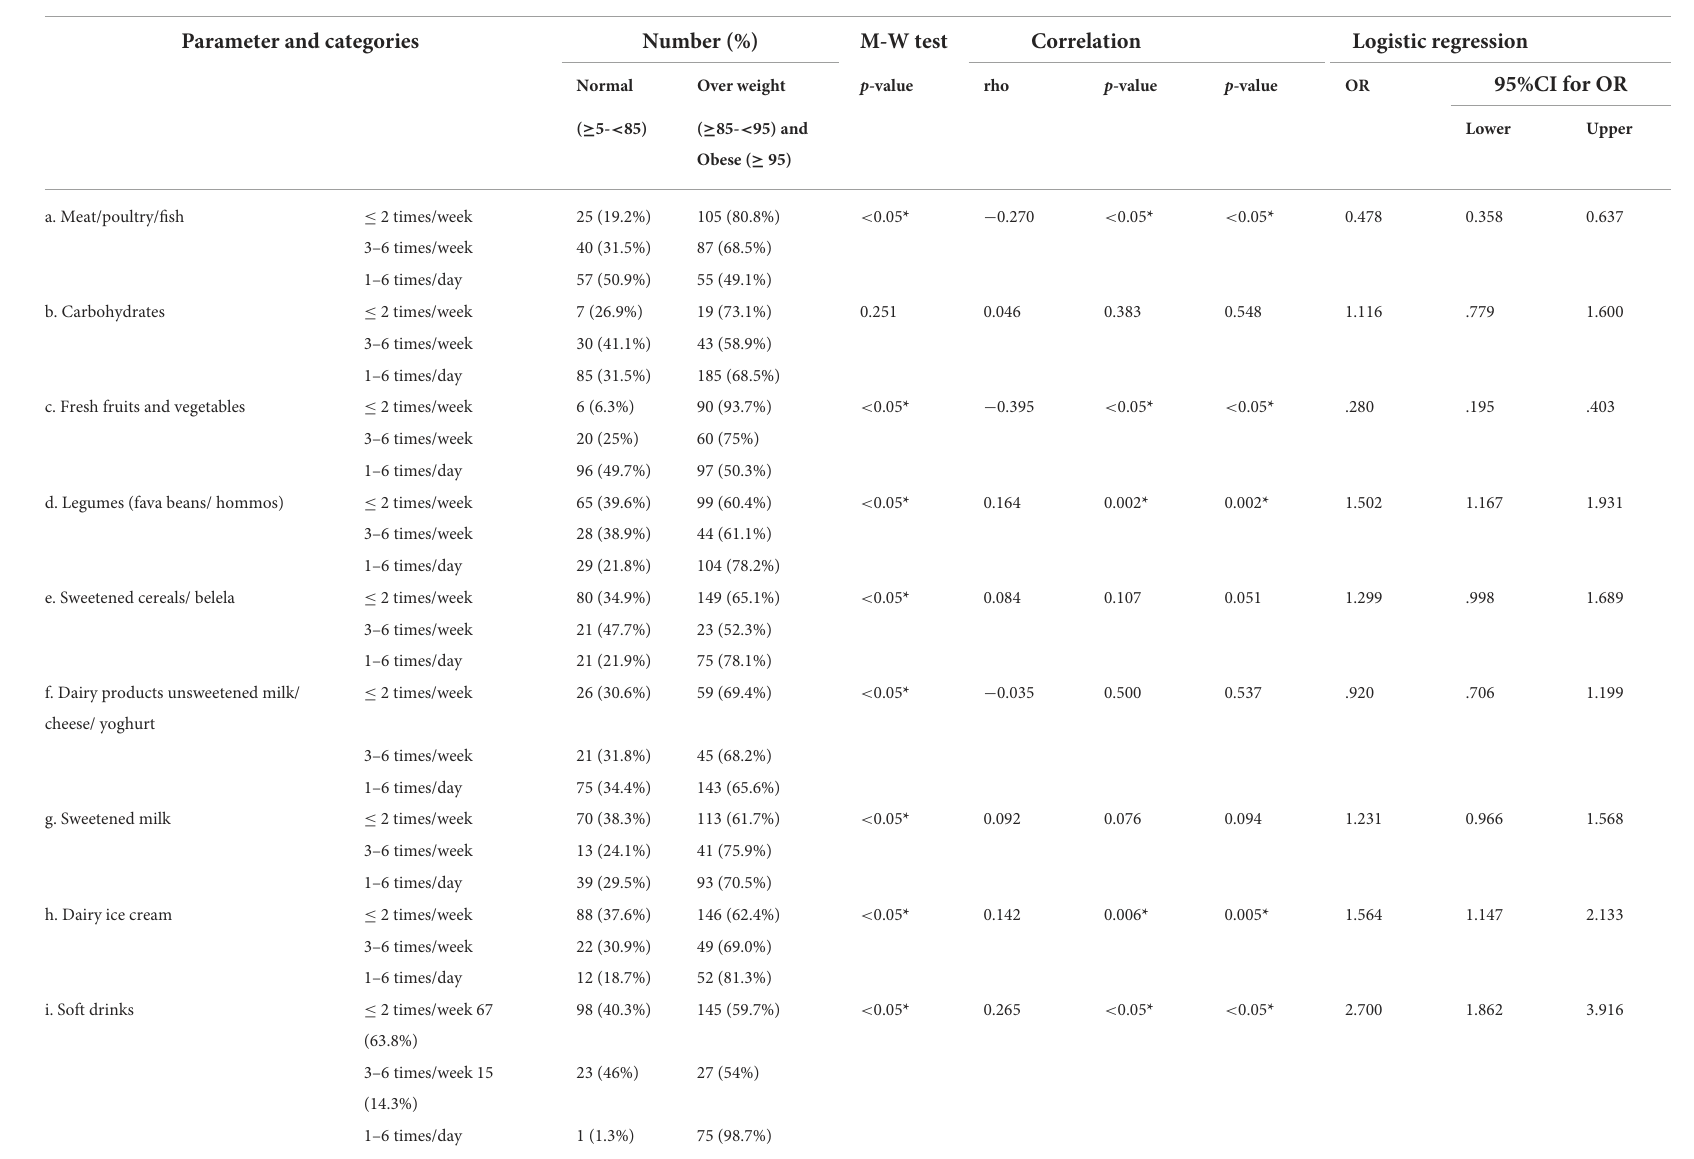
TABLE 11 Correlation between BMI and frequency of intake of different food items (Total number 369). Dietary habits Parameter and categories M-W test Correlation Logistic